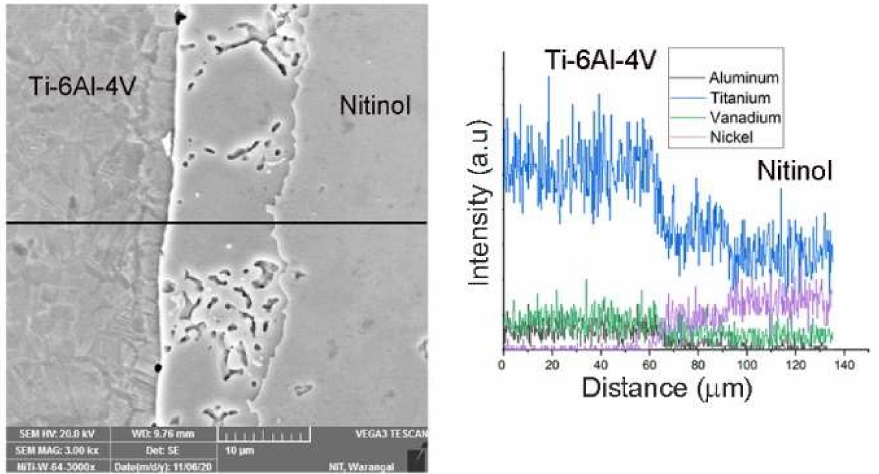
Figure 6. SEM image of the Ti-6Al-4V/Nitinol joint and the corresponding SEM energy dispersive spectroscopy (EDS) line scan.